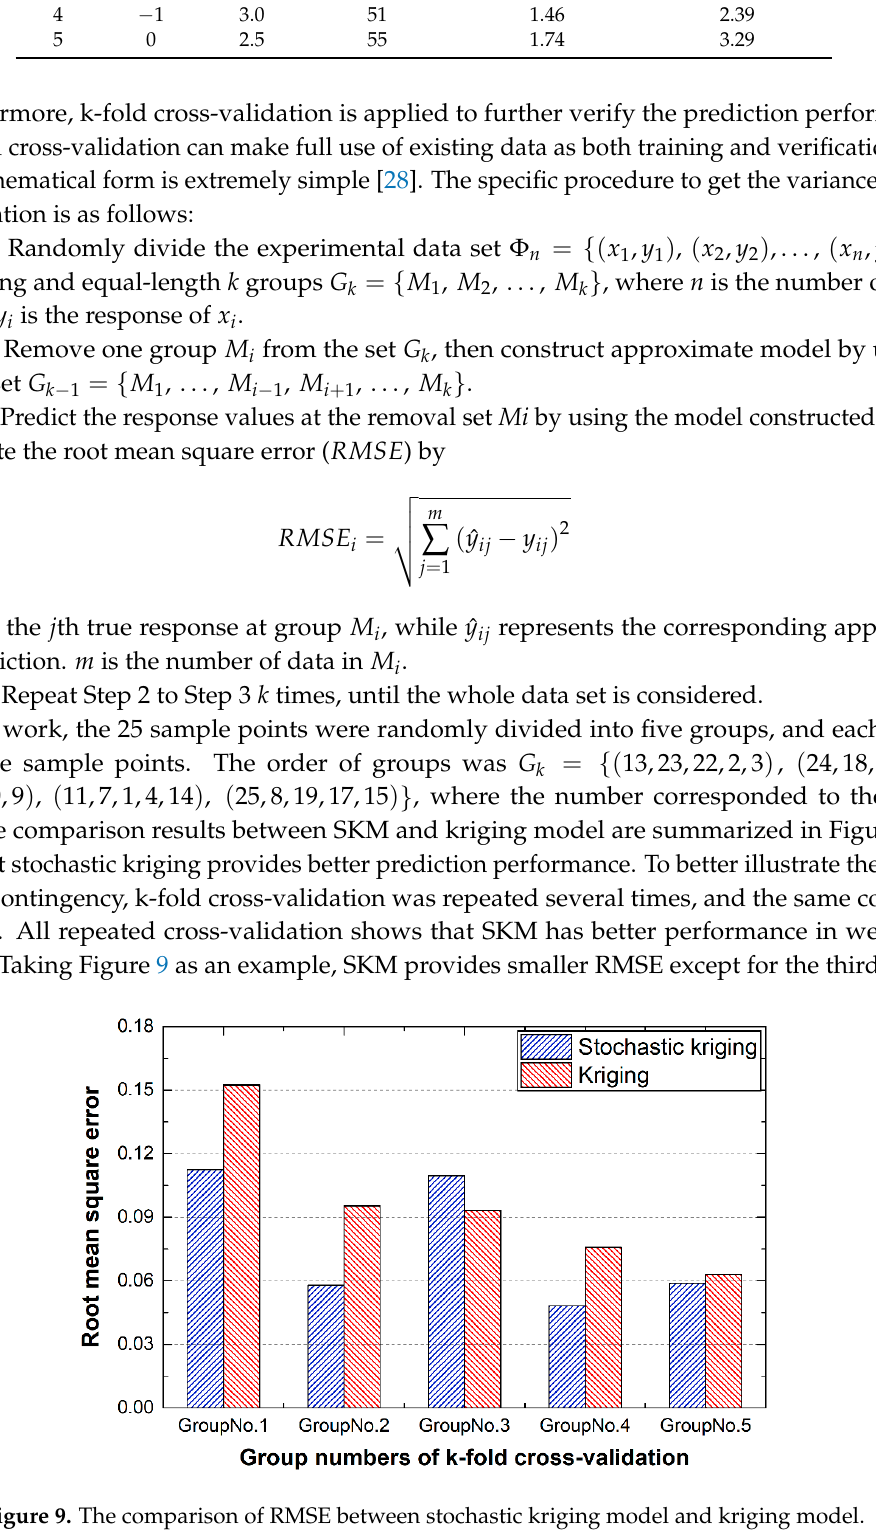
Table 4. Weld bead of additional test points.